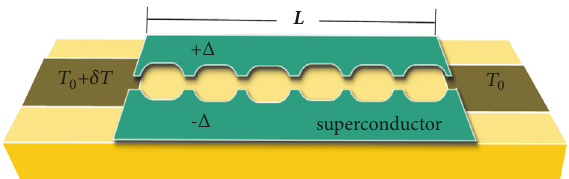
Figure 1: By varying the sample’s length 𝐿 , we can go from a quantum dot to a chain of dots, which in the continuous limit is a quantum wire. The conducting device is bounded by supercon- ductors with a phase difference of 𝜋 (order parameters given by ±Δ ) and connected to electron reservoirs with different temperaturesvia ideal